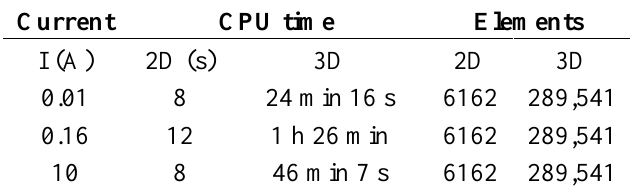
Table 1. Computational cost for the 2D and 3D simulations with τ =